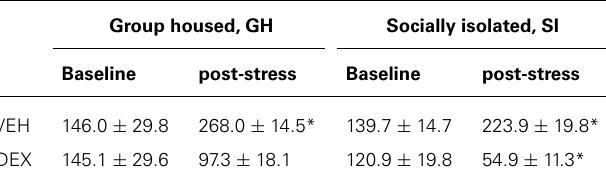
Table 2 | Group housed (GH) and socially isolated (SI) rats were re-tested using the dexamethasone (DEX) suppression test after 6 weeks of ethanol (EtOH) self-administration in a homecage, intermittent access